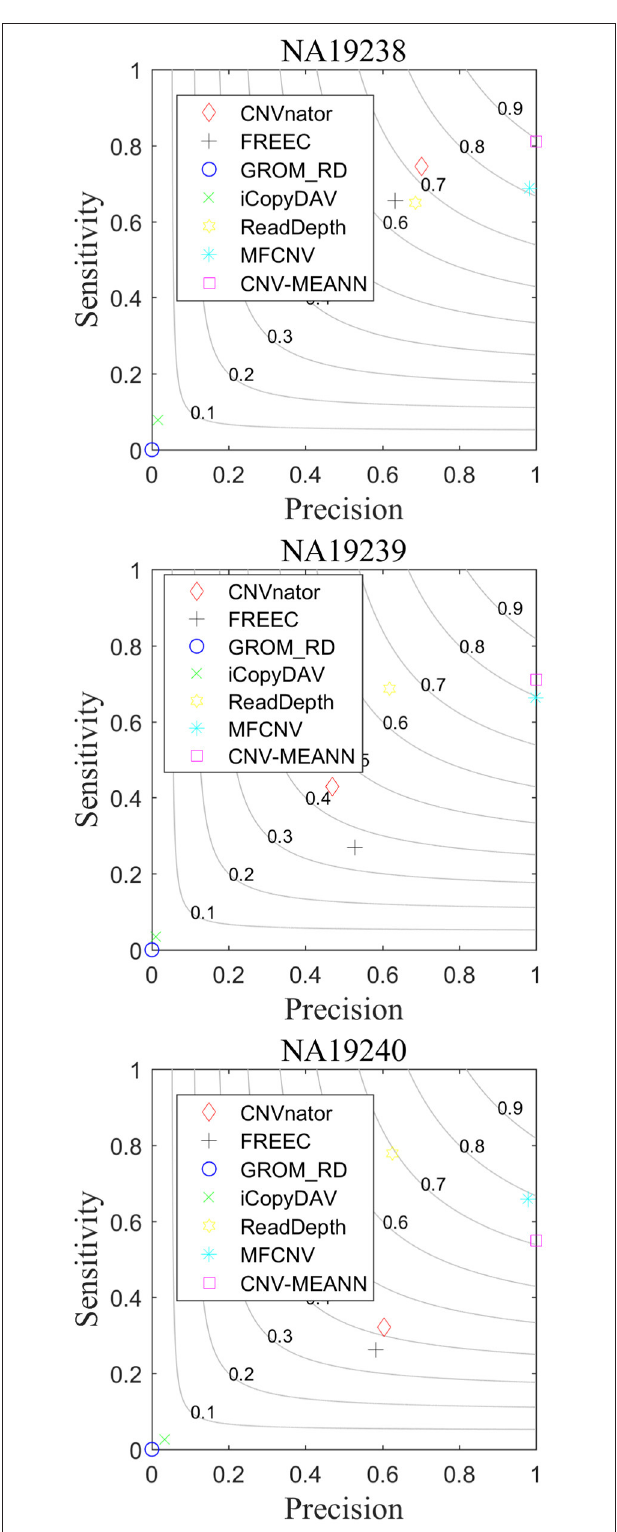
FIGURE 8 | Performance comparison of the six methods on real sequencing